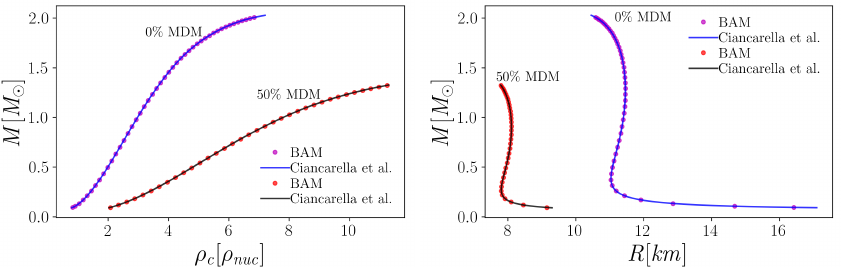
Figure 1. Left : Total mass values as a function of the total central density of the neutron star, for a pure baryonic star (blue line, magenta dots) and 50% mirror dark matter admixed star (black line, red dots). The density is expressed in units of the nuclear saturation denisty. The SLy EoS is used for both plots. Right : Total mass as a function of the radius, for the same neutron star models. The lines show data obtained as described in Ciancarella et al. [26] and the overplotted dots result from our updated BAM version.